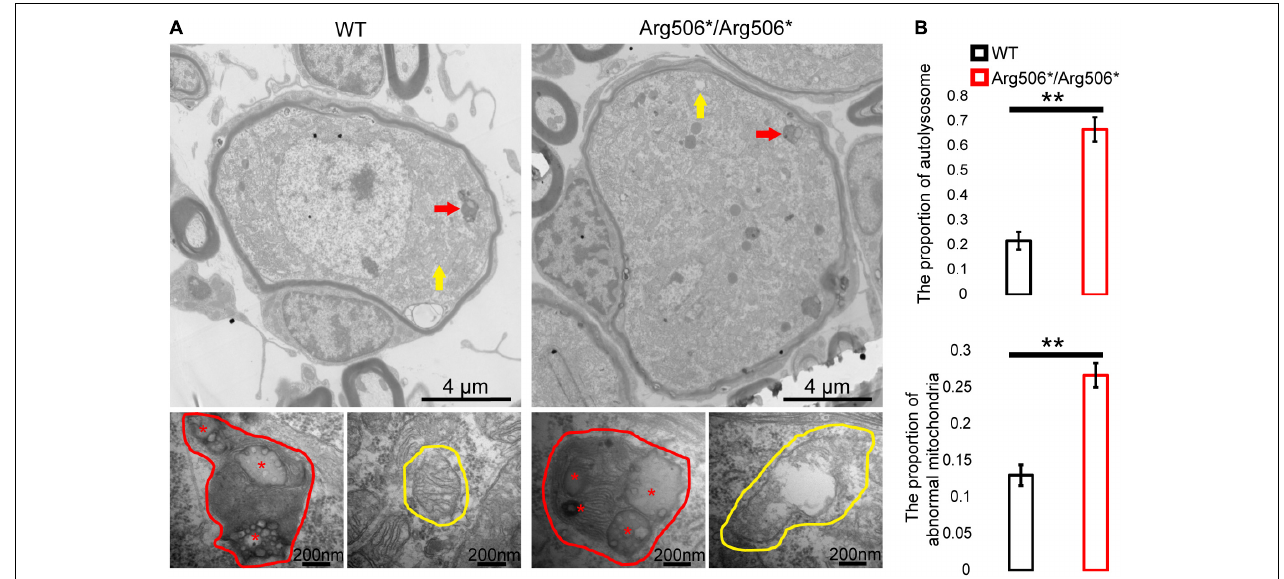
FIGURE 4 | Transmission electron microscopy images of the organelles of SGNs in Atp6v1b2 Arg 506 ∗ / Arg 506 ∗ and WT mice. (A) Red arrows and red circles indicate the locations and enlarged views of a typical autophagy lysosome, respectively. Yellow arrows and yellow circles indicate the locations and enlarged views of mitochondria, respectively. In Atp6v1b2 Arg 506 ∗ / Arg 506 ∗ mice, increased degraded substrates indicated by red asterisks in the autophagy lysosomes of the spiral ganglion neurons (SGNs) were observed, and some of the mitochondria appeared swollen. Most of the mitochondria in the SGNs showed normal morphology in WT mice. (B) The percentage of autolysosomes and abnormal mitochondria significantly increased in Atp6v1b2 Arg 506 ∗ / Arg 506 ∗ mice. The t -test was performed to evaluate statistical significance. The percentage of autolysosomes in lysosomes and the percentage of abnormal mitochondria were manually determined. Each group included three mice, and one slice for each mouse was processed. Data are described as mean ± SEM (standard error of mean). ** denotes P <